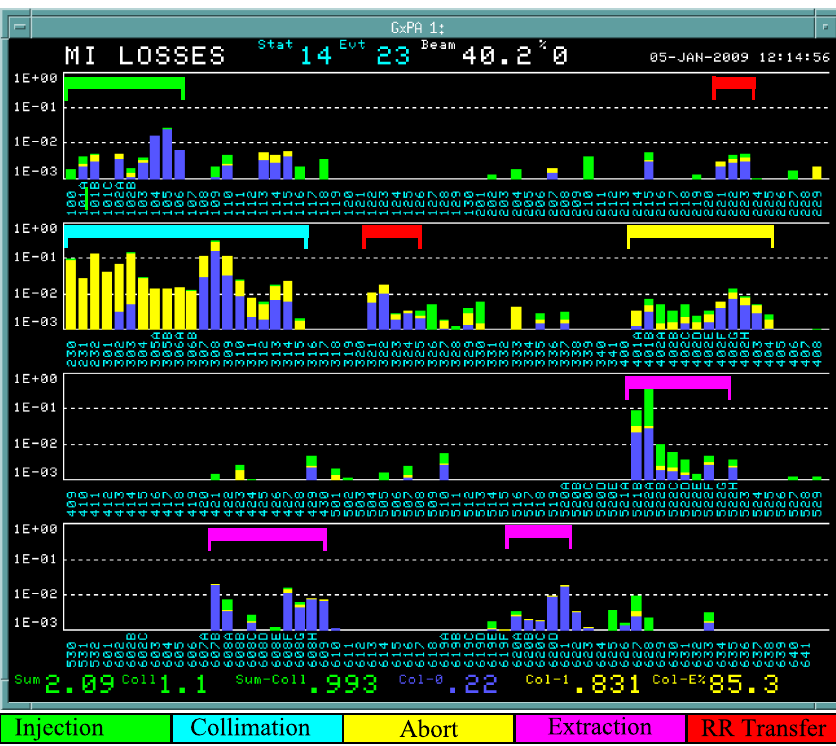
FIG. 2. Beam loss monitor display from a Main Injector cycle in January 2009 at an intensity of 4 : 4 (cid:1) 10 13 protons. The three decade logarithmic vertical scale in rads = pulse ranges from 1 millirad to 1 rad. Values shown are integrated loss at each BLM in the ring at the end of the cycle in green, overlaid in yellow by loss integral after 1.5% acceleration, then overlaid in blue by the loss integral at the end of injection. In typical operation, most of the green loss results from the extraction process at the very end of the cycle. Functional areas of the ring are marked by colored braces that are identified below the